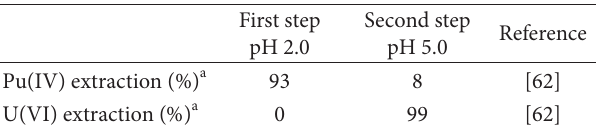
-dichlorobenzene. 𝑜𝑜 T 6: Successive extractions of Pu(IV) and U(VI) by 21 (extrac- tion ( ) at each step). %